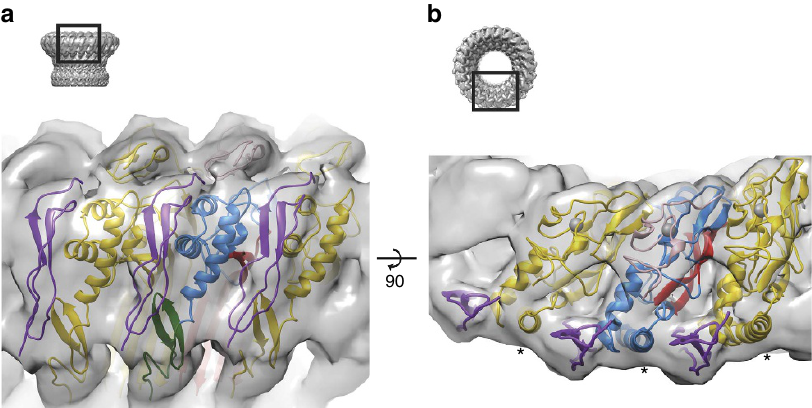
Figure 2 | Interactions made by the TSP1 domain. ( a ) A view of the outside of the globular portion of the poly-C9 map showing the TSP1 domain (purple) located at each subunit interface. The central C9 monomer is coloured as in Fig. 1, with the monomers each side in dark yellow and purple (TSP1 domain). ( b ) A view from the top showing placement of the TSP1 domain between the C-terminal helix (marked with *) of each MACPF domain.